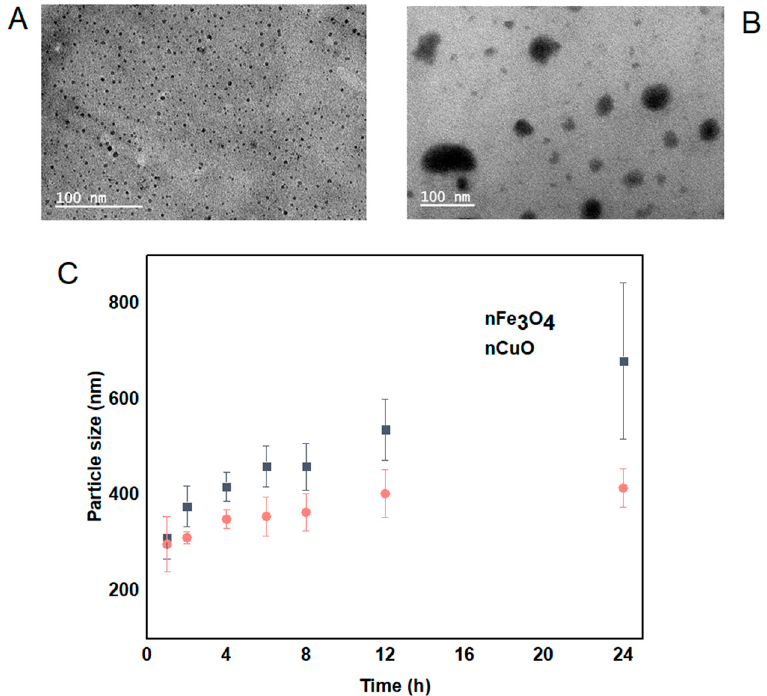
Figure 1. Transmission electron microscopic image of nCuO ( A ) and nFe 3 O 4 ( B ). Particle size distribution (nm) during a 24 h time periods by dynamic light scattering for nFe 3 O 4 and nCuO ( C ).